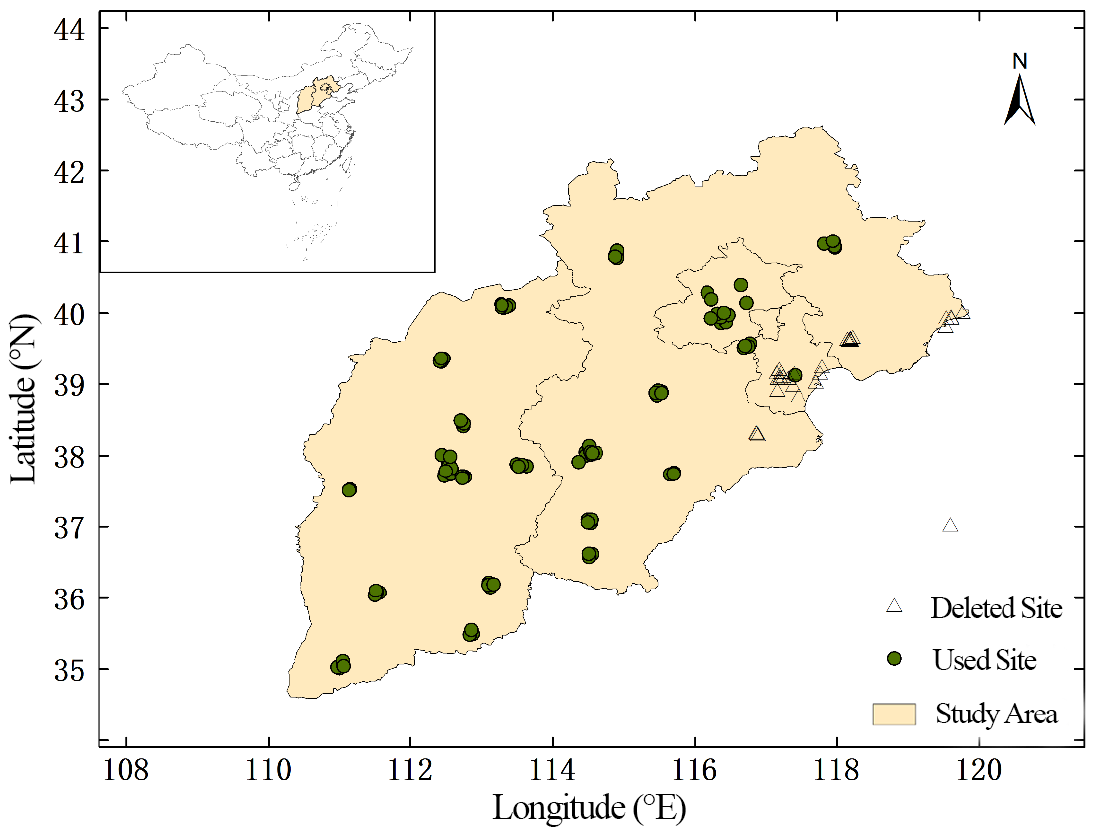
Figure 1. The study area including Beijing, Tianjin, Hebei, and Shanxi, and the PM 2.5 monitoring sites. The circle and triangle symbols are the PM 2.5 monitoring sites, but the triangle symbols have lower accuracy of the model prediction.